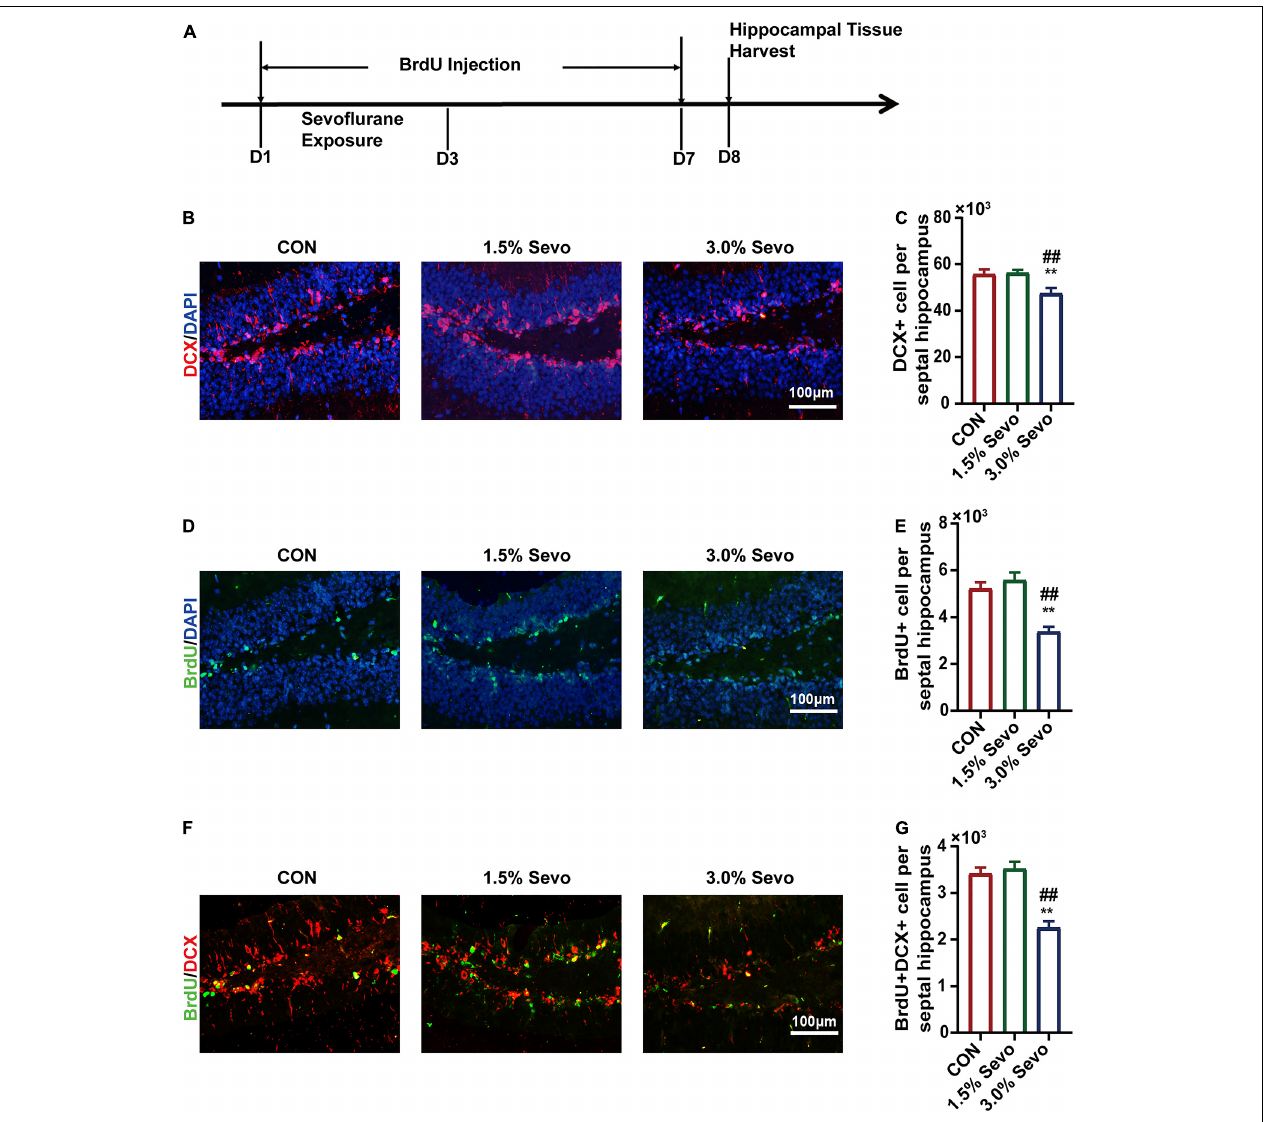
FIGURE 3 | The inhibition of DCX+ cells, BrdU+ cells, and BrdU+DCX+ cells is induced by 3% sevoflurane in the hippocampi of aged mice. (A) Timeline of the immunofluorescence experimental procedure. (B) Representative immunofluorescence images of DCX+ cells in aged mice. (C) Quantitative analysis of DCX+ cells in aged mice. (D) Representative immunofluorescence images of BrdU+ cells in aged mice. (E) Quantitative analysis of BrdU+ cells in aged mice. (F) Representative immunofluorescence images of BrdU+DCX+ cells in aged mice. (G) Quantitative analysis of BrdU+DCX+ cells in aged mice. Values are the mean ± S.E.M. ** p < 0.01 compared with the CON group. ## p < 0.01 compared with the 1.5% Sevo group ( n = 8/group). D, days of experimental procedure; BrdU, 5-Bromodeoxyuridine; DCX, doublecortin; CON, control group; 1.5% Sevo, 1.5% sevoflurane group; 3.0% Sevo, 3.0% sevoflurane